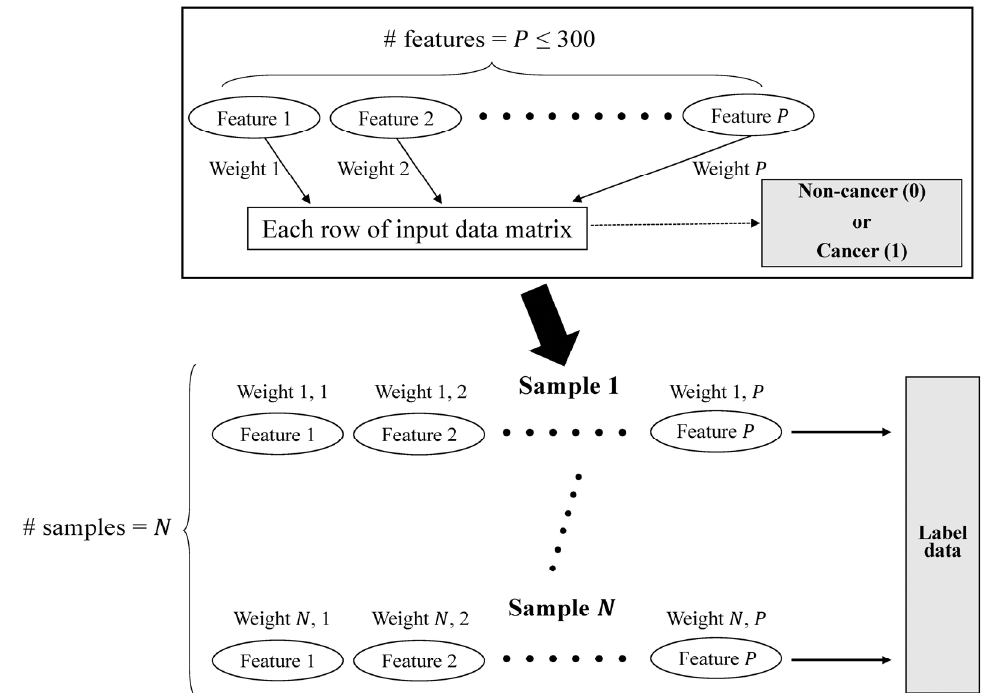
Figure 1. Data schema characterized by directed acyclic graph (DAG) structure. The DAG architec- ture is implemented to label the multi-omics data. This data-label flow is to avoid potential data duplication derived from graph-based